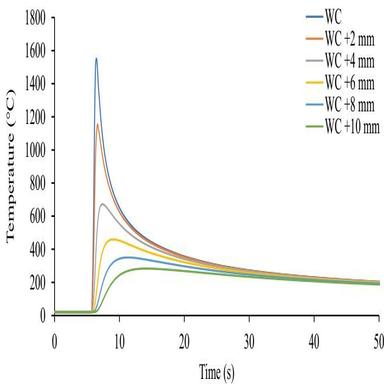
Predicted temperature profiles during welding at 2 mm intervals from the weld centre (WC).